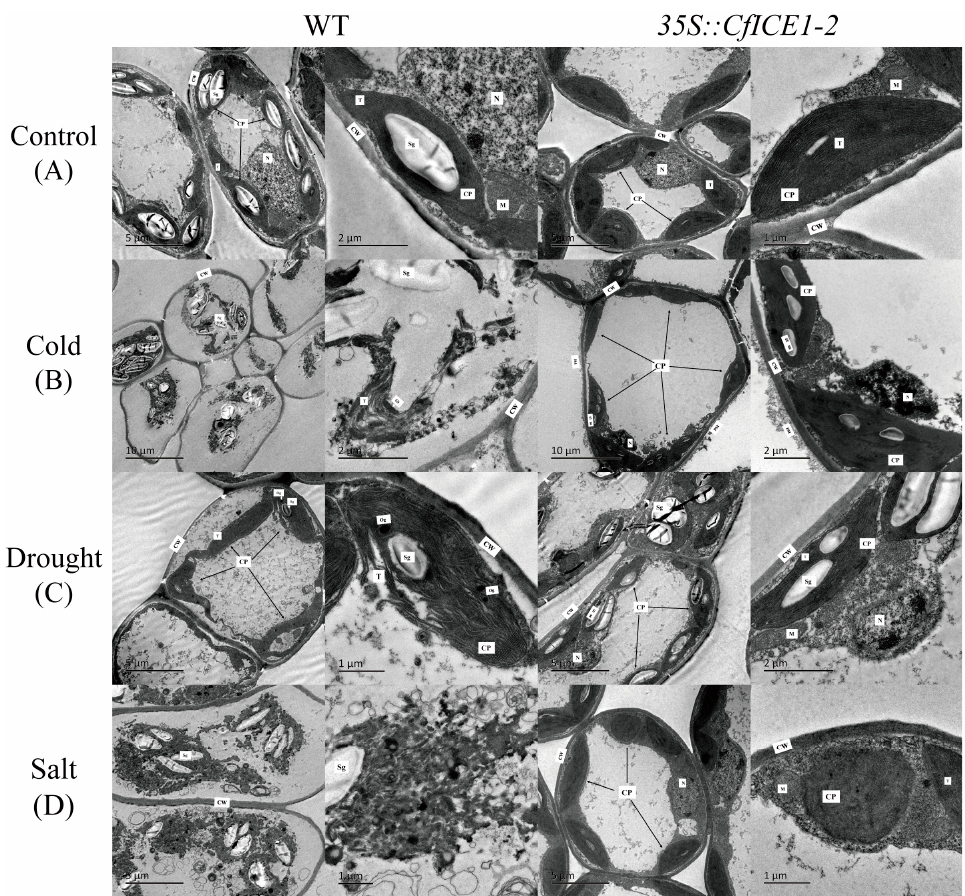
Figure 8. Ultrastructure of leaves of 35S:: CfICE1 ‐ 2 and WT poplar lines under different stress conditions. CW: cell wall; PM: plasma membrane; N: nucleus; CP: chloroplast; M: mitochondrion; Sg: starch grain; T: thylakoid slice layer; Gt: granum ‐ thylakoids.